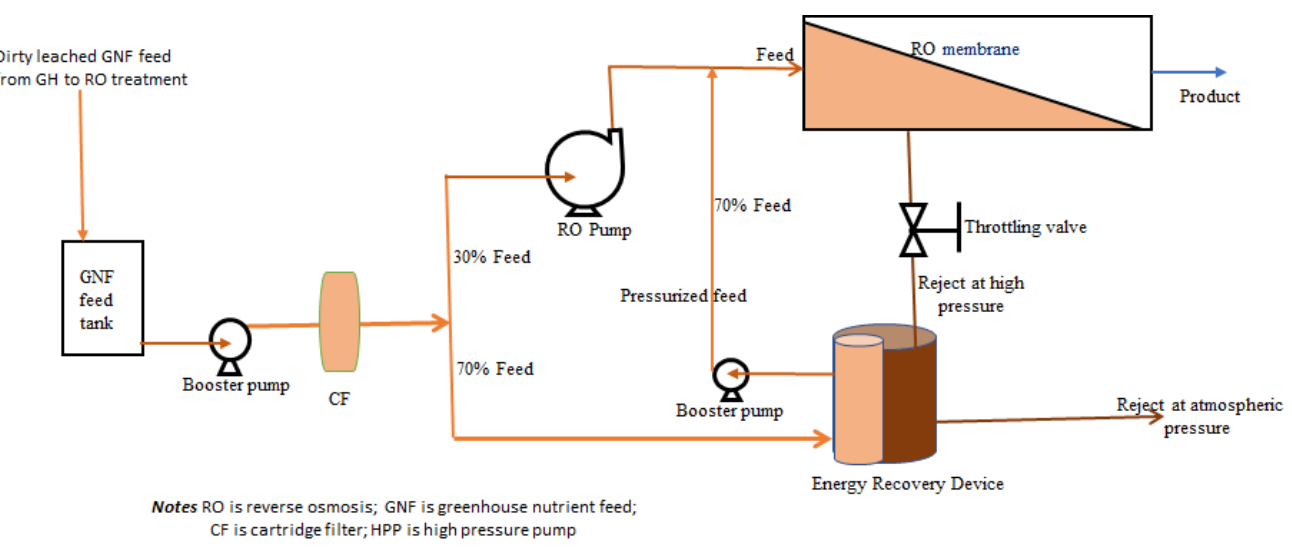
Figure 7. Simplified schematic diagram of an energy economic RO design.